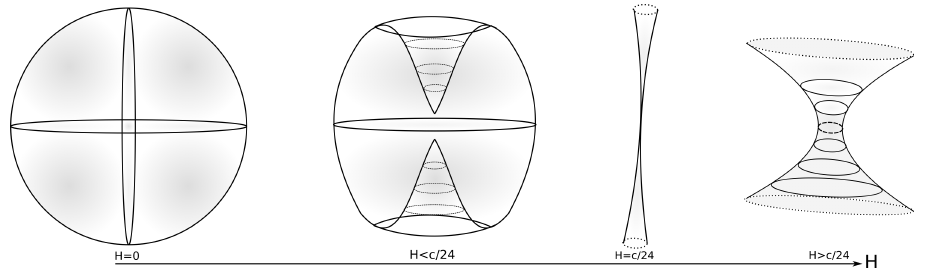
Figure 3 . A set of examples of effective geometries of the primary state | H i as the scaling weight H is varied. Notice the transition in topology at H = c/ 24